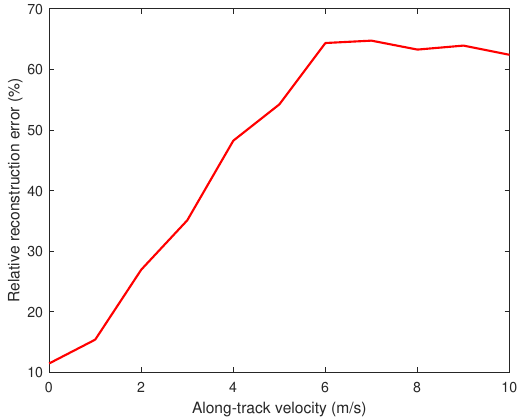
Figure 7. Relative reconstruction error versus along-track velocity.